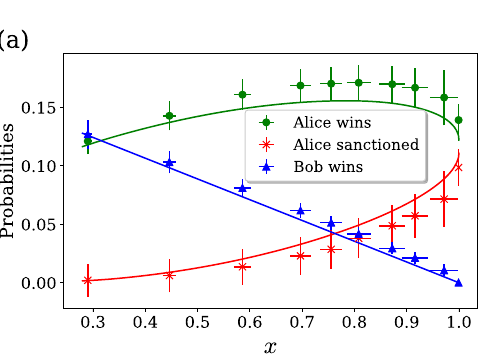
on these ef fi ciencies. a Probabilities of different outcomes. b Alice ’ s cheating interestfordifferentdeterrentfactors δ .Thedashedblacklineindicatesthepoints of maximum